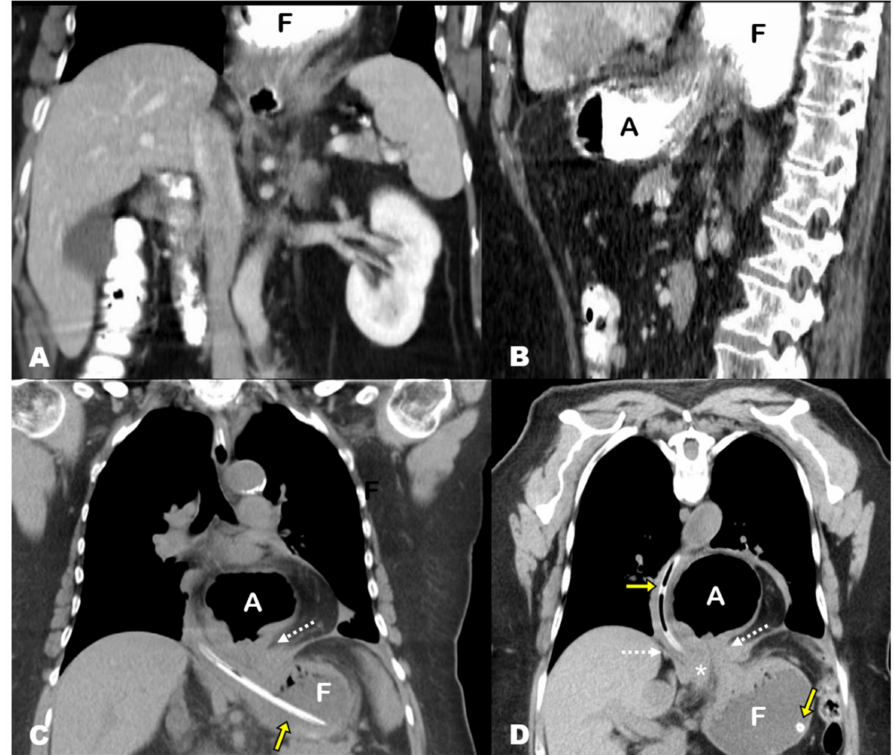
Figure 2. ( A , B ) Contrast-enhanced abdominal CT after oral contrast administration 5 years prior to the acute presentation, coronal and sagittal MPR views. The superior slices of the images show a hiatal hernia containing the gastric fundus (F). The antrum lies below the diaphragm, and there is no evidence of the esophagogastreal junction because it lies superiorly and was not included in the study (sliding hernia). ( C , D ) Non-contrast chest CT scan, coronal and oblique-coronal MPR views. The antrum (A) lies above the diaphragm, and the fundus (F) is re-herniated through the esophageal hiatus (note the hernia neck, dotted arrow). The antropiloric junction originates from the posterior part of the antrum and lies to the right side of the esophageal hiatus (asterisk). These findings indicate that the fundus, which was previously located in the mediastinum, re-herniated into the abdominal cavity, triggering the gastric volvulus. Note the nasogastric tube in the fundus (yellow arrows).